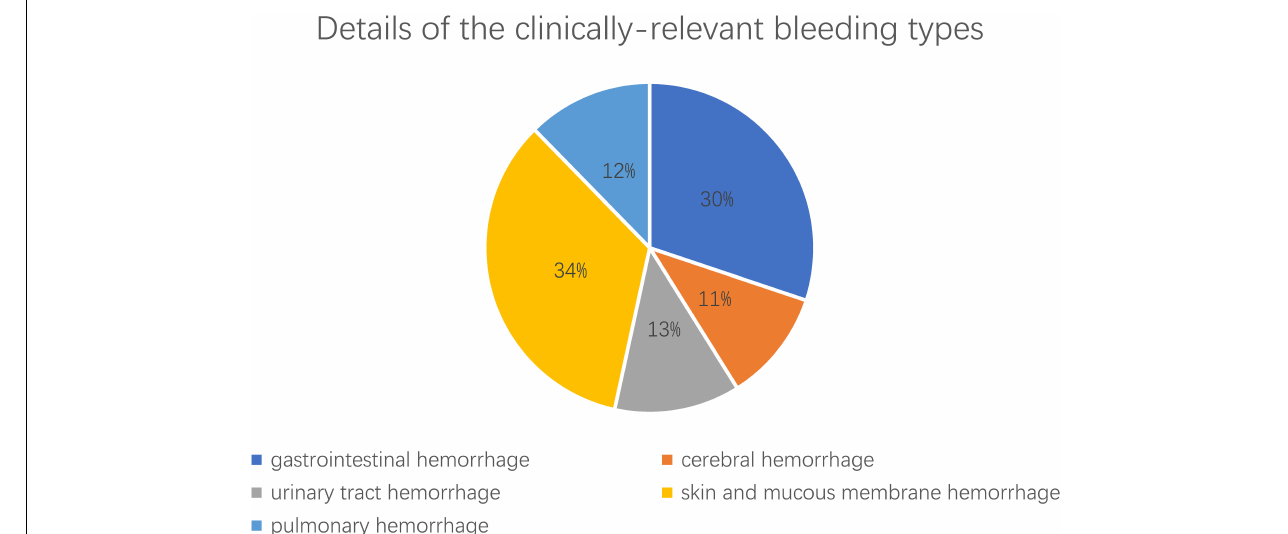
FIGURE 1 | The details of the clinically relevant bleeding types after PCI. Clinically relevant bleeding complications (BARC = type 2–5, excluding BARC 4) including 22 (30%) cases of gastrointestinal hemorrhage, 8 (11%) cases of cerebral hemorrhage, 9 (13%) cases of urinary tract hemorrhage, 25 (34%) cases of skin and mucous membrane hemorrhage, and 9 (12%) cases of pulmonary hemorrhage.